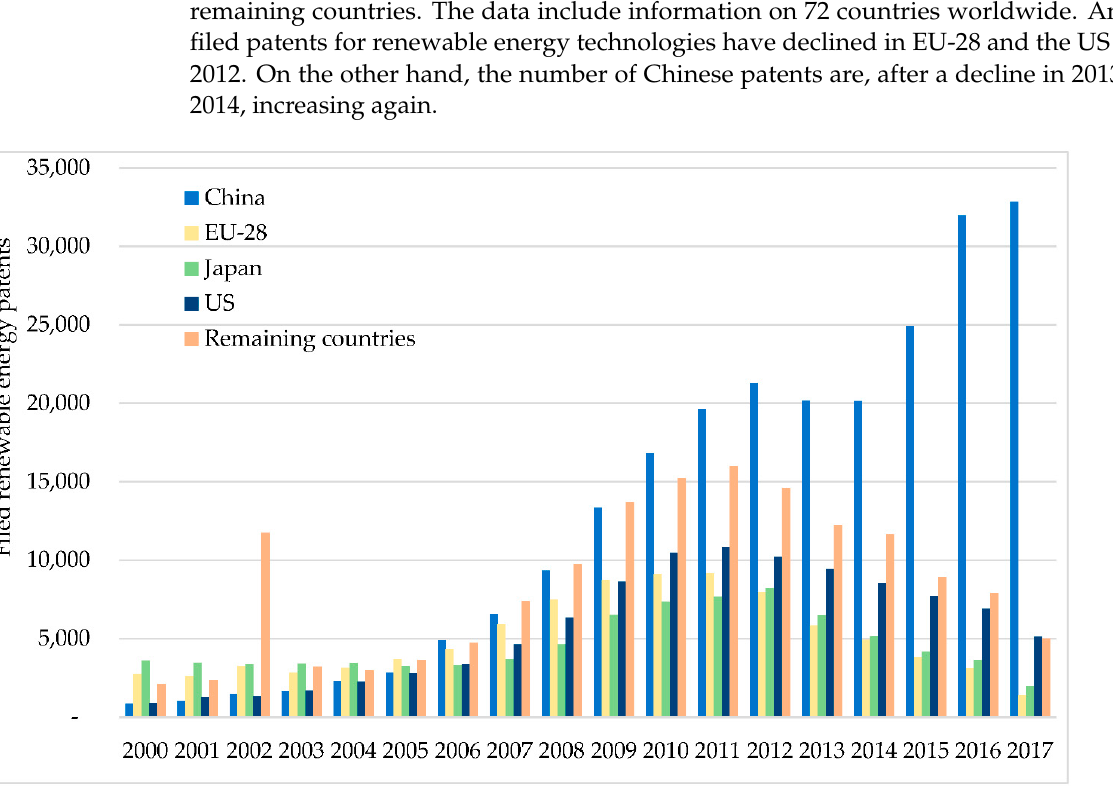
Figure 4. Development of renewable energy patents in China, the EU ‐ 28, Japan, the US and remain ‐ ing countries (based on